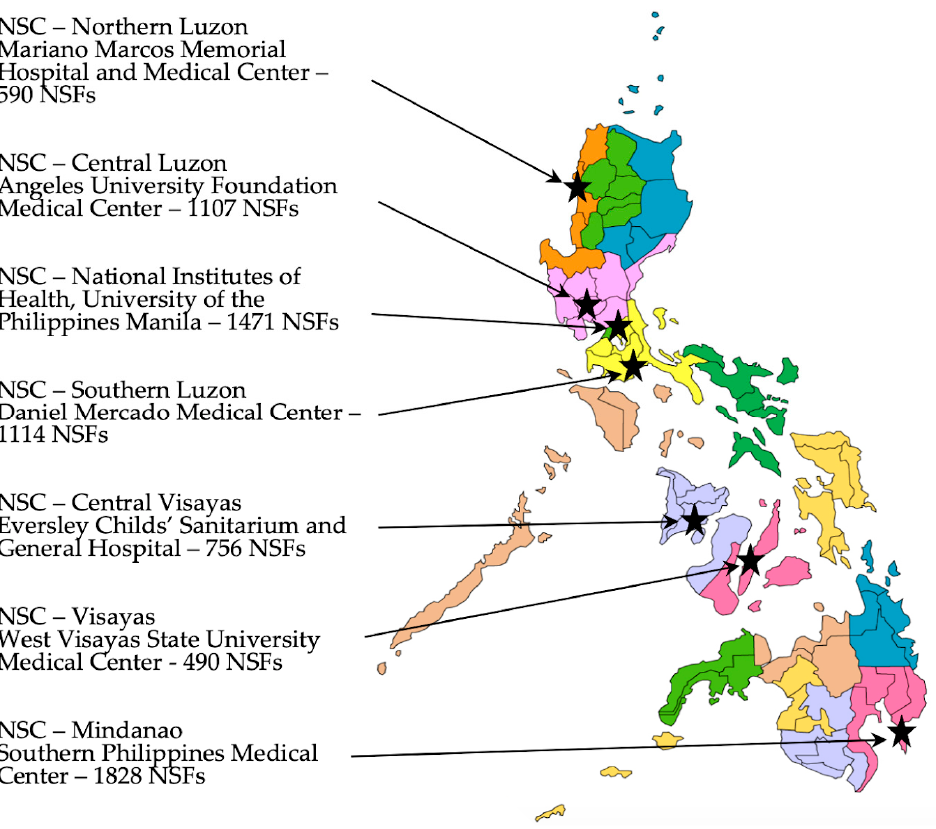
Figure 1. Location map of the seven Newborn Screening Centers (NSCs) currently providing screen- ing laboratory services along with the number of Newborn Screening Facilities (NSFs) served by each. The seventeen different government regions are illustrated by the different colors.